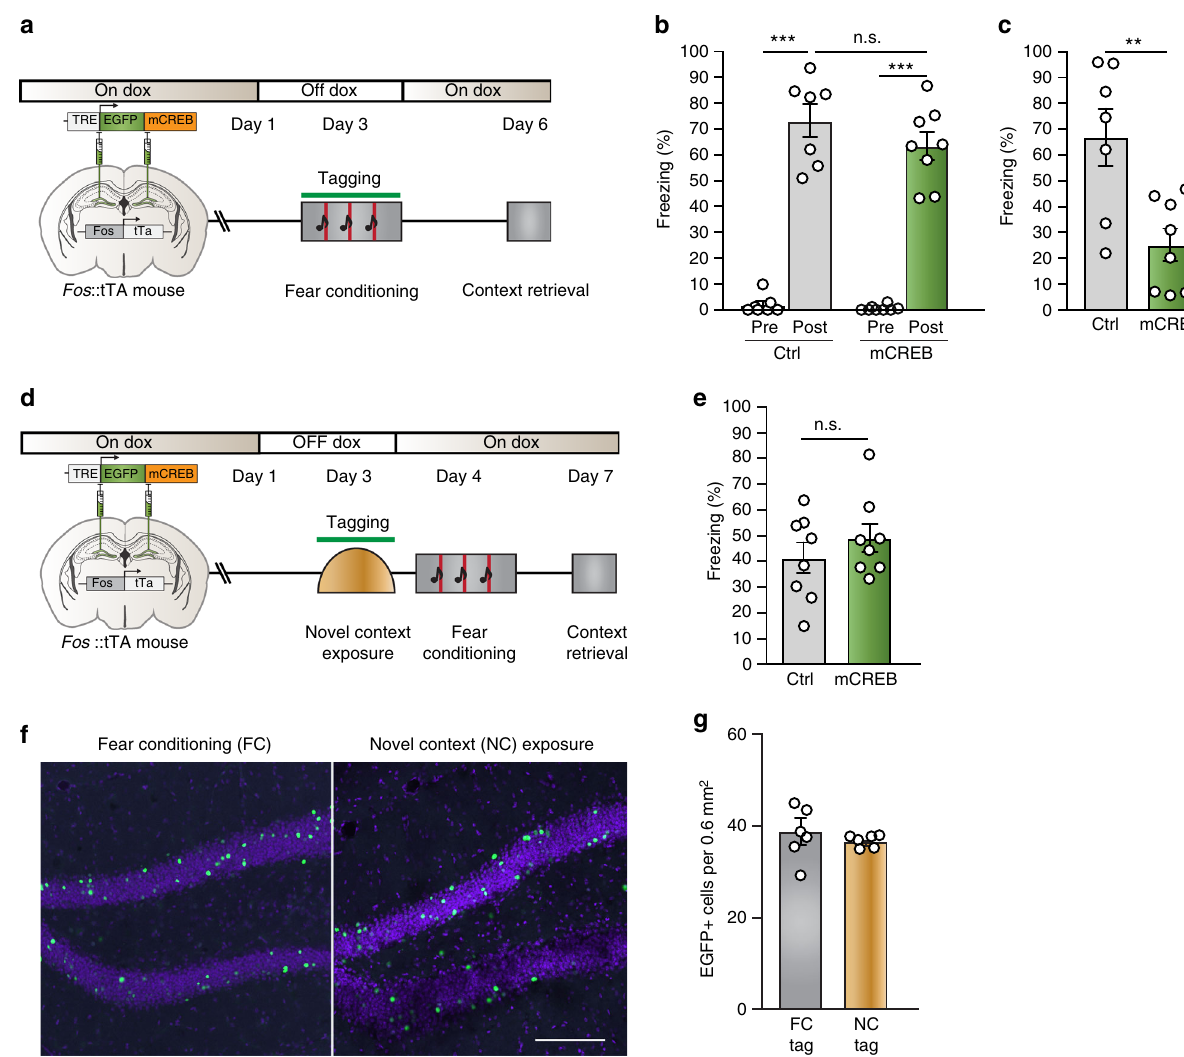
Fig. 5 DG engram-speci fi c disruption of CREB function impairs memory consolidation. a Experimental design. Fos ::tTA mice were injected with